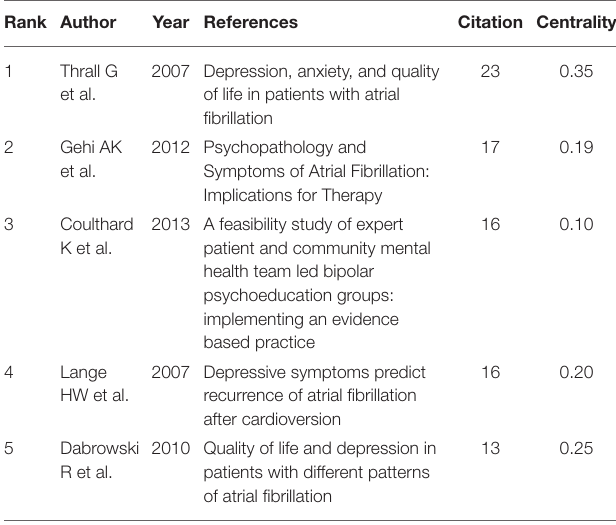
TABLE 3 | Top 5 co-cited references on atrial fibrillation and depression.